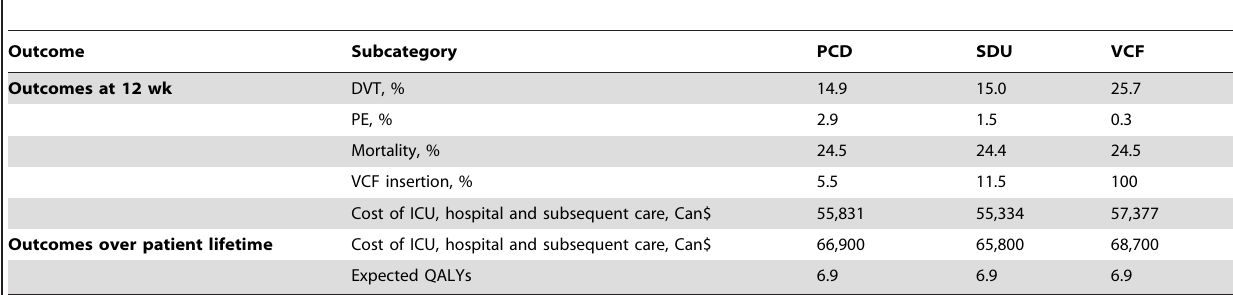
Table 4. Clinical outcomes and costs for patients receiving three venous thromboembolism prophylaxis